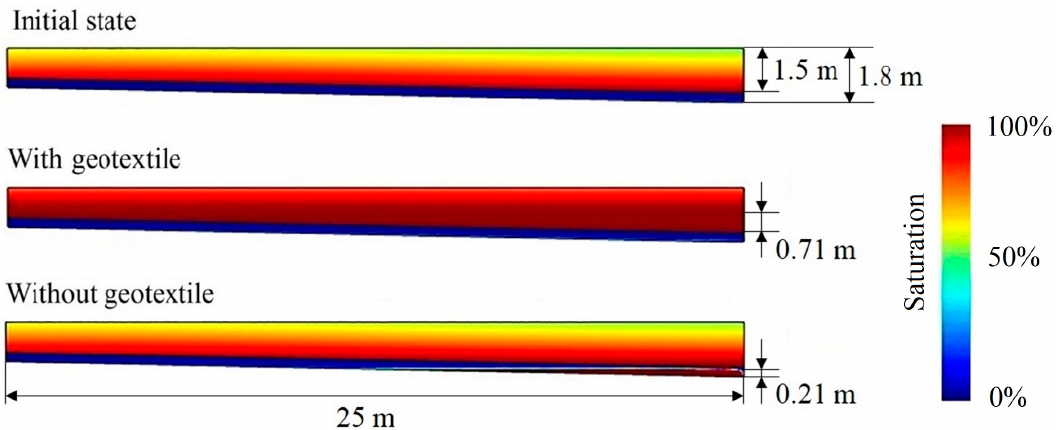
Figure 8. Degree of saturation in the waste layer and LCS (geotextile thickness 2 mm, drainage length 25 m, gravel diameter 20 mm, and slope to drains 2%).